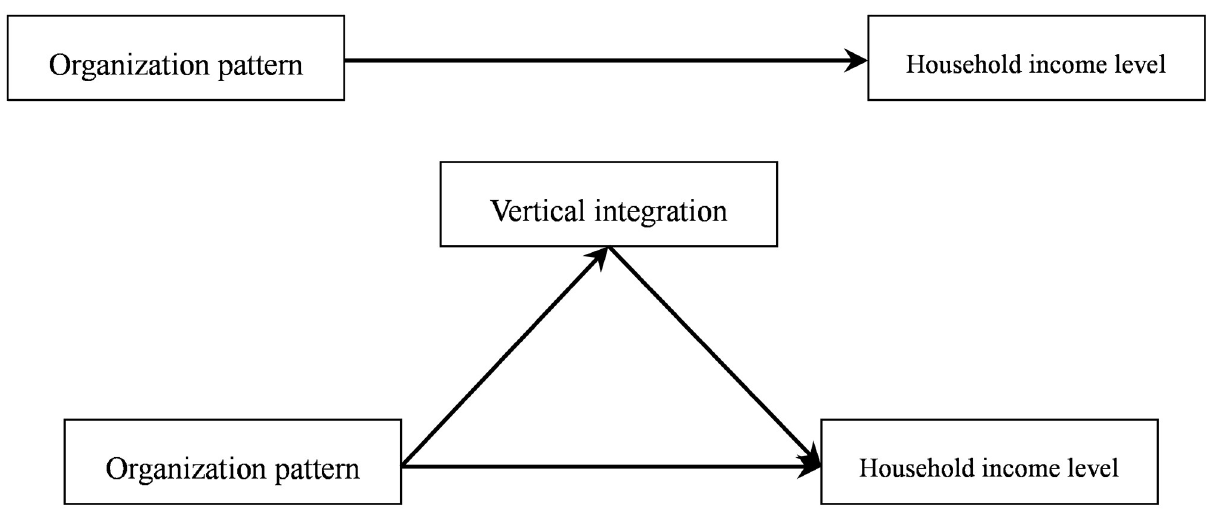
Fig 1. Influence path